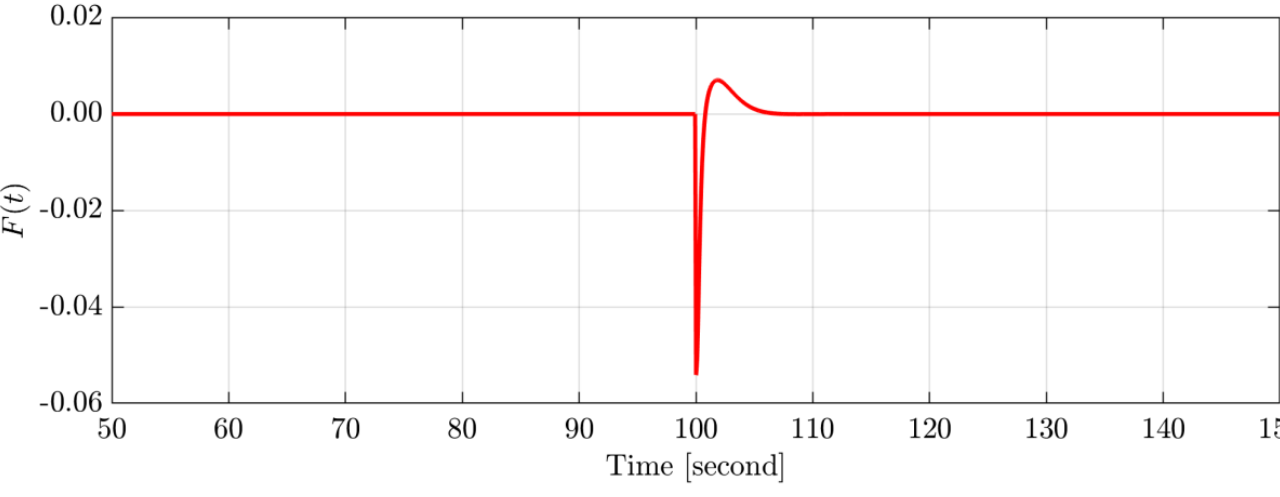
Figure 8. The ULM parameter ( F ) for the studied system ’ s inputs and outputs.